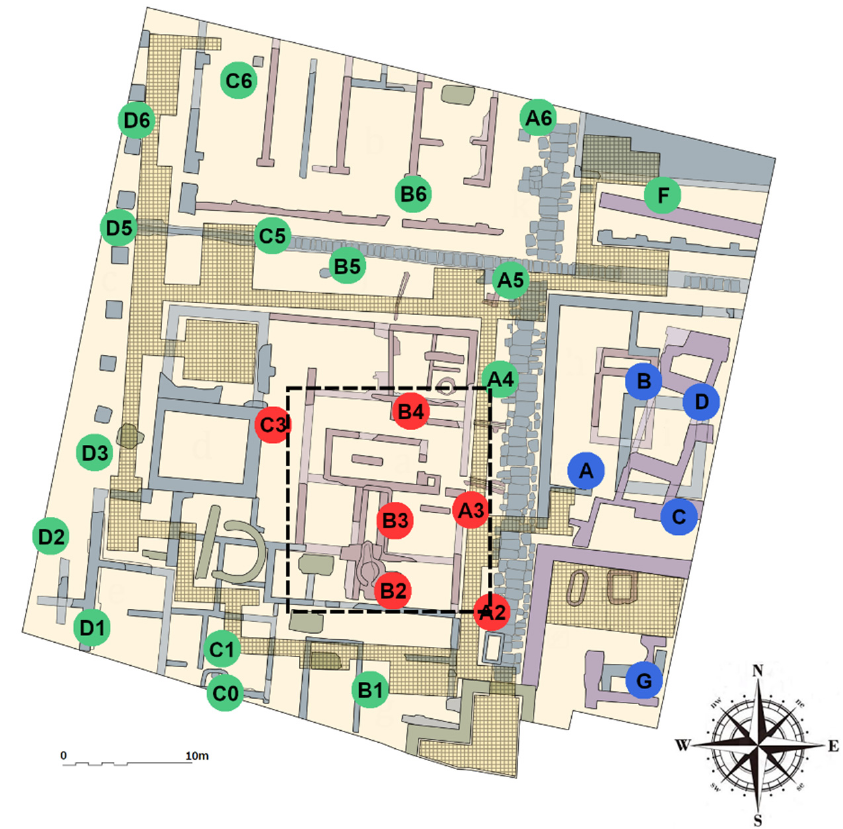
Figure 1. Position of 27 data-loggers installed at the Archaeological Center of l’Almoina [46]. Color codes indicate similarity in the pattern of recorded temperatures. The position of the skylight is marked as a dashed rectangle in black. The walkway used to visit the museum is indicated as a light-brown graticule (grid area).